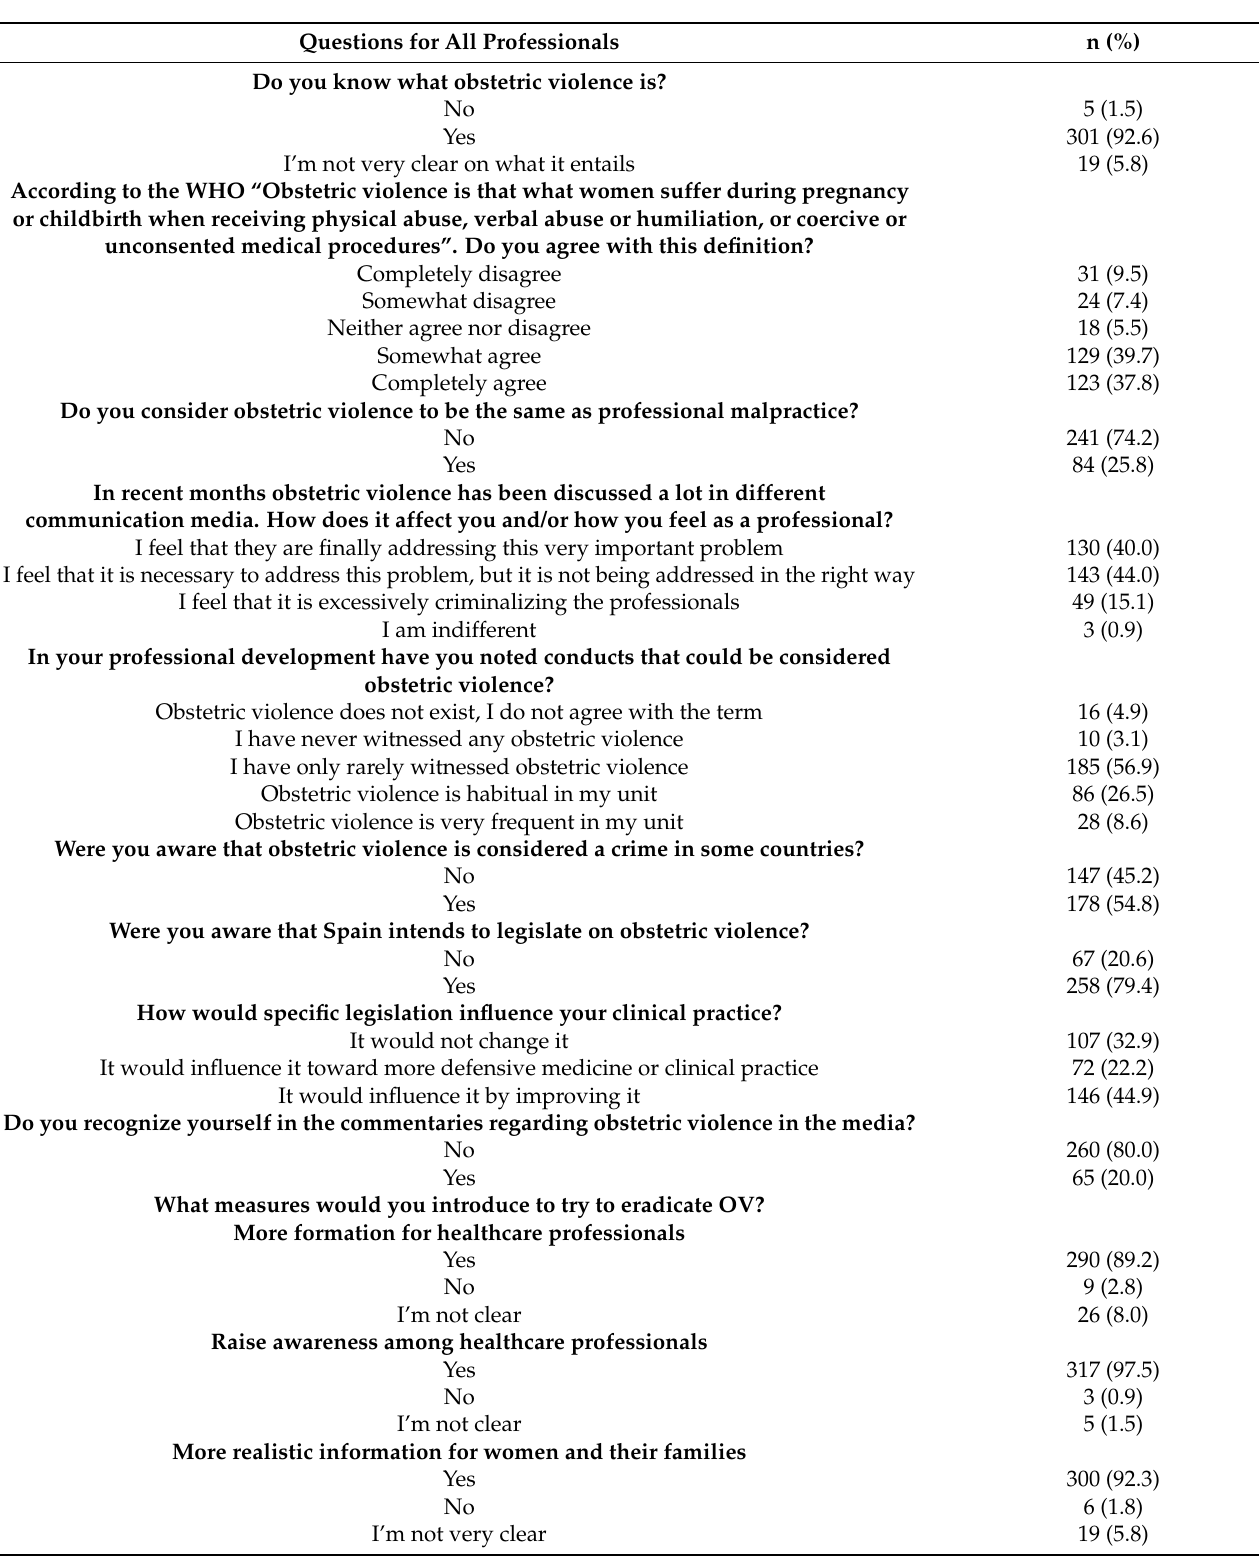
Table 2. Questions regarding the perception of obstetric violence and its